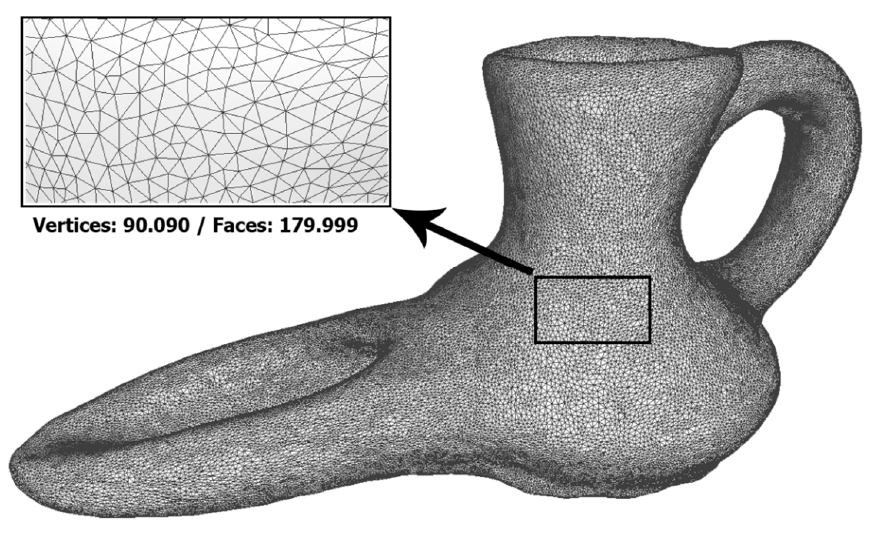
Figure 13. Meshed obtained by photogrammetry. (Source: self-made).